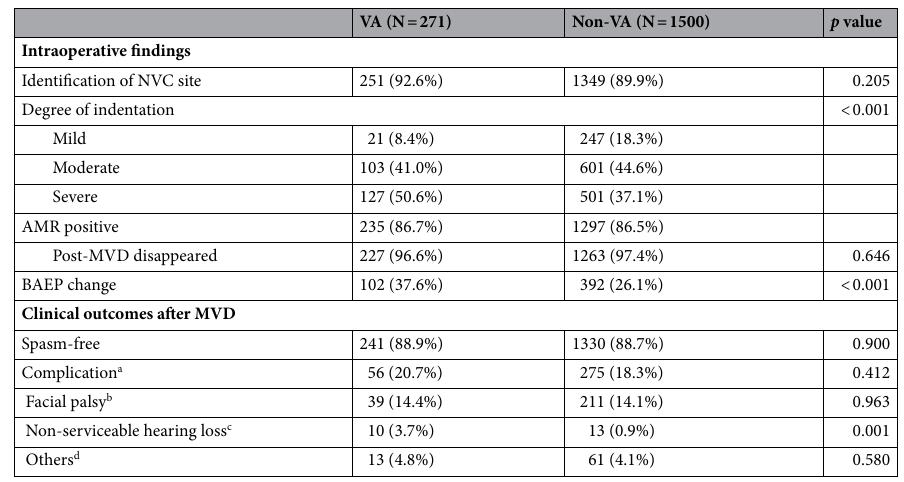
Table 3. Intraoperative findings and clinical outcomes of VA-involved and non-VA-involved HFS. HFS hemifacial spasm, VA vertebral artery, NVC neurovascular compression, AMR abnormal muscle response, BAEP brainstem auditory evoked potential, MVD microvascular decompression. a A patient might have more than one complication. b Facial palsy included both immediate and delayed type. c The hearing loss included a sensorineural type only. d Others included wound infection, aseptic meningitis, suspicious or definite cerebrospinal fluid leakage, vocal cord palsy, asymptomatic subdural hematoma, transient abducens nerve palsy, and